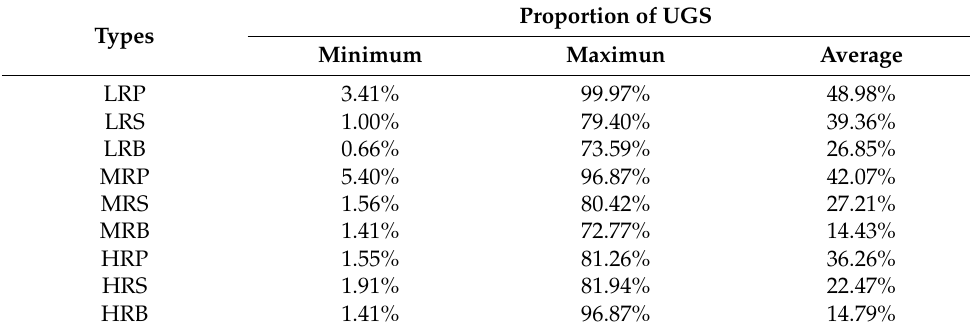
Table 4. Composition of UGS among different urban blocks.